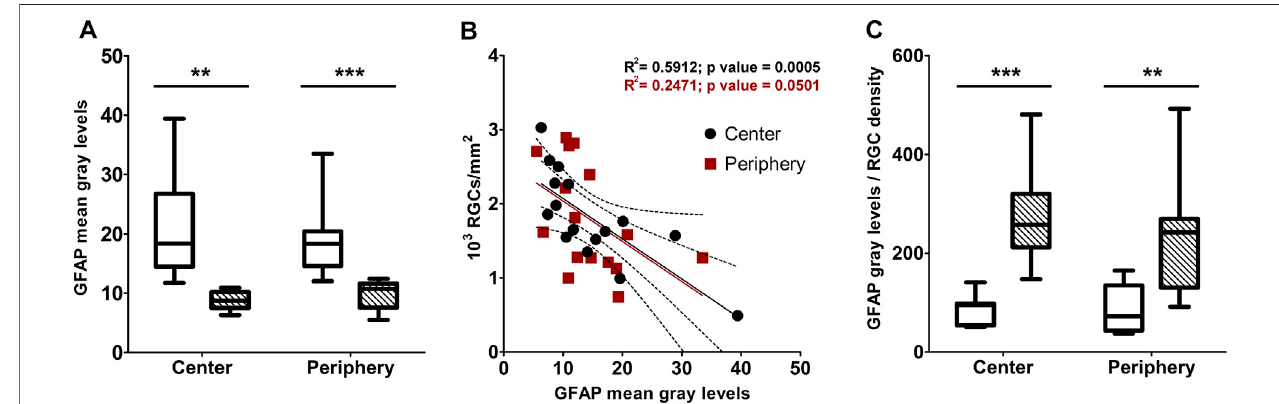
FIGURE 6 | (A) densitometric analysis of GFAP immunostaining in central and peripheral areas of D2 (white box) and D2+LG (dashed boxes). (B) correlation of GFAP immuno fl uorescence levels with the correspondent RGC density per optical fi led in central and peripheral retinal areas. (C) ratio between GFAP immunostaining and RGC density in central and peripheral retinal areas of D2 (white box) and D2+LG (dashed boxes) mice. Box plots describe the statistical distribution of n (cid:1) 4 independent retinas. Data were analyzed using two-way ANOVA with Bonferroni post-hoc test. ** p < 0.01, *** p <